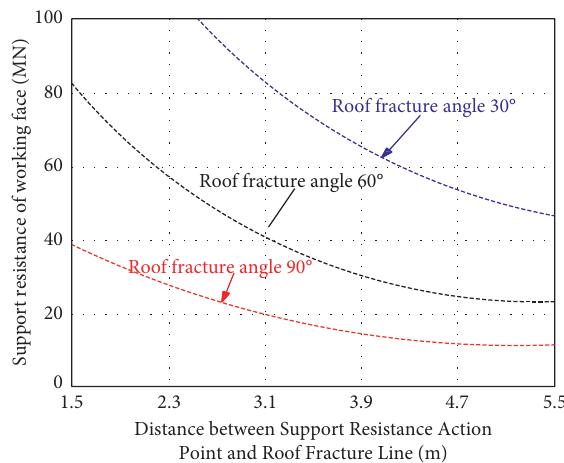
Figure 7: The relationship between support resistance and point action.